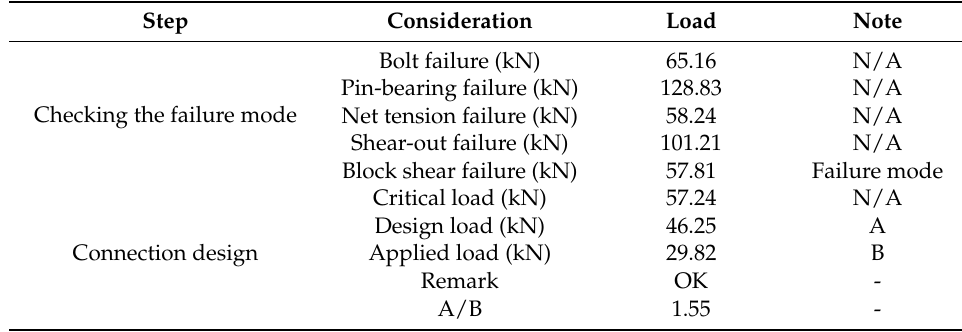
Table 6. Result of design on the connection system.